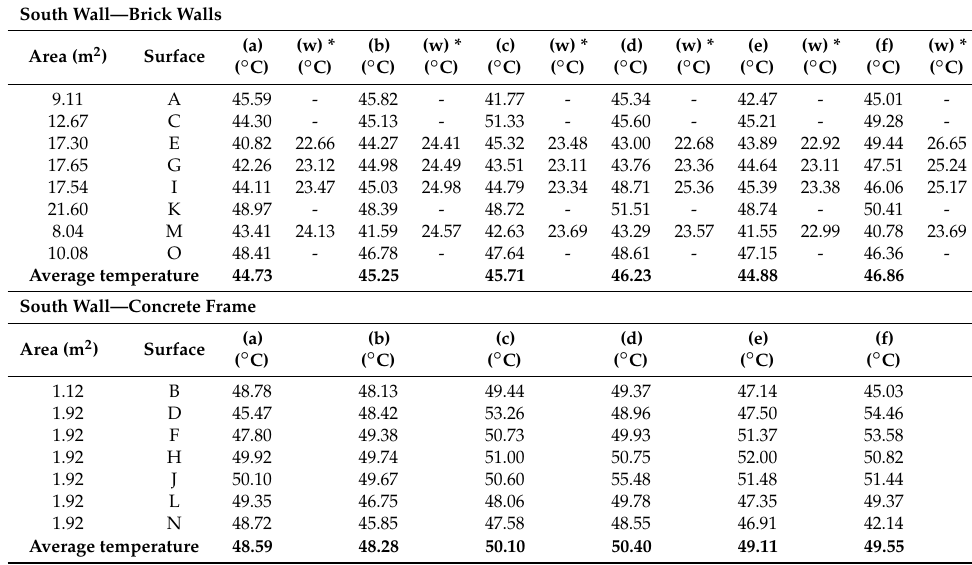
Table 1. Simulated temperatures of the south wall for the initial configuration (a) and for the five case studies where positions/orientations of the fan heaters were changed (b–f).